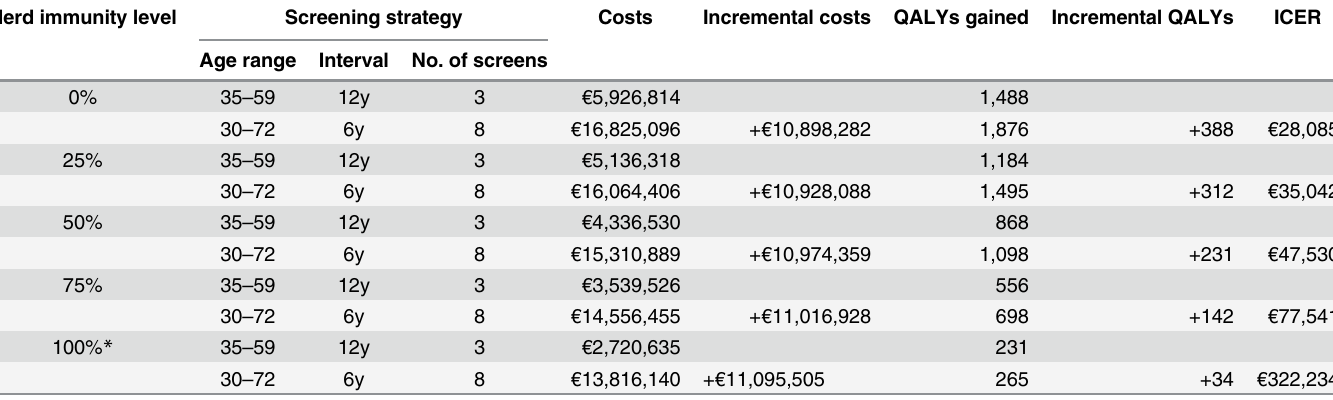
Table 3. Base case costs and QALYs gained as compared to no screening (both 3% discounted) of screening optimized to a pre-vaccinated cohort and of screening optimized to a vaccinated cohort, and incremental cost-effectiveness of the former strategy as compared to the latter. For differ- ent levels of herd immunity, results are given per 100,000 unvaccinated women.